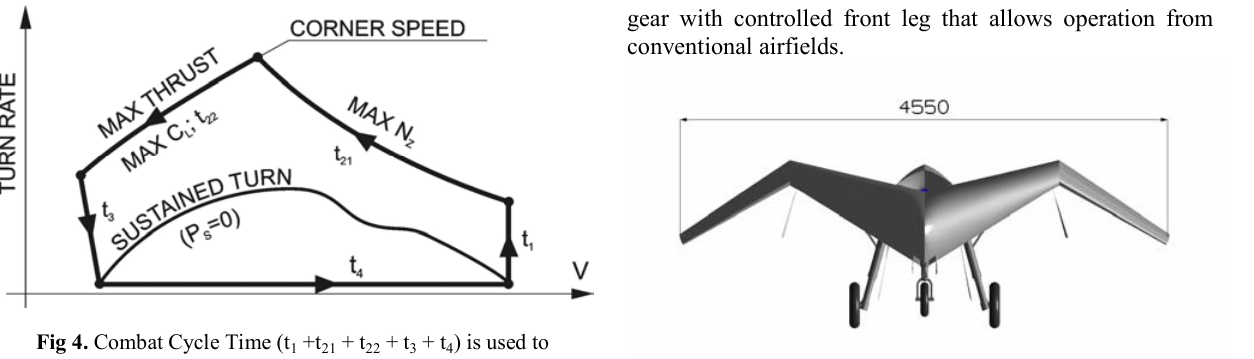
Fig 4. Combat Cycle Time (t 1 +t 21 + t 22 + t 3 + t 4 ) is used to measure combat agility, from [29]